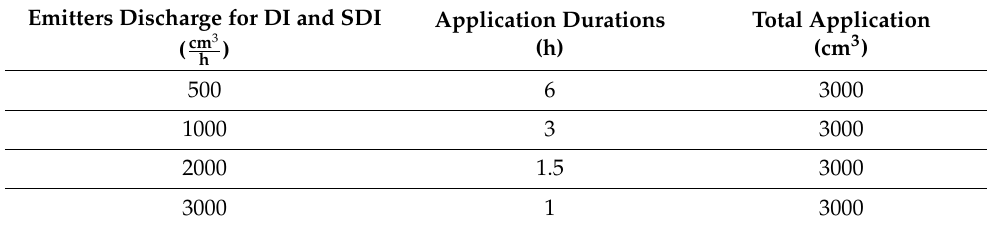
Table 1. Emitters discharge, time table for each simulation and total water application of DI and SDI. Emitters Discharge for DI and